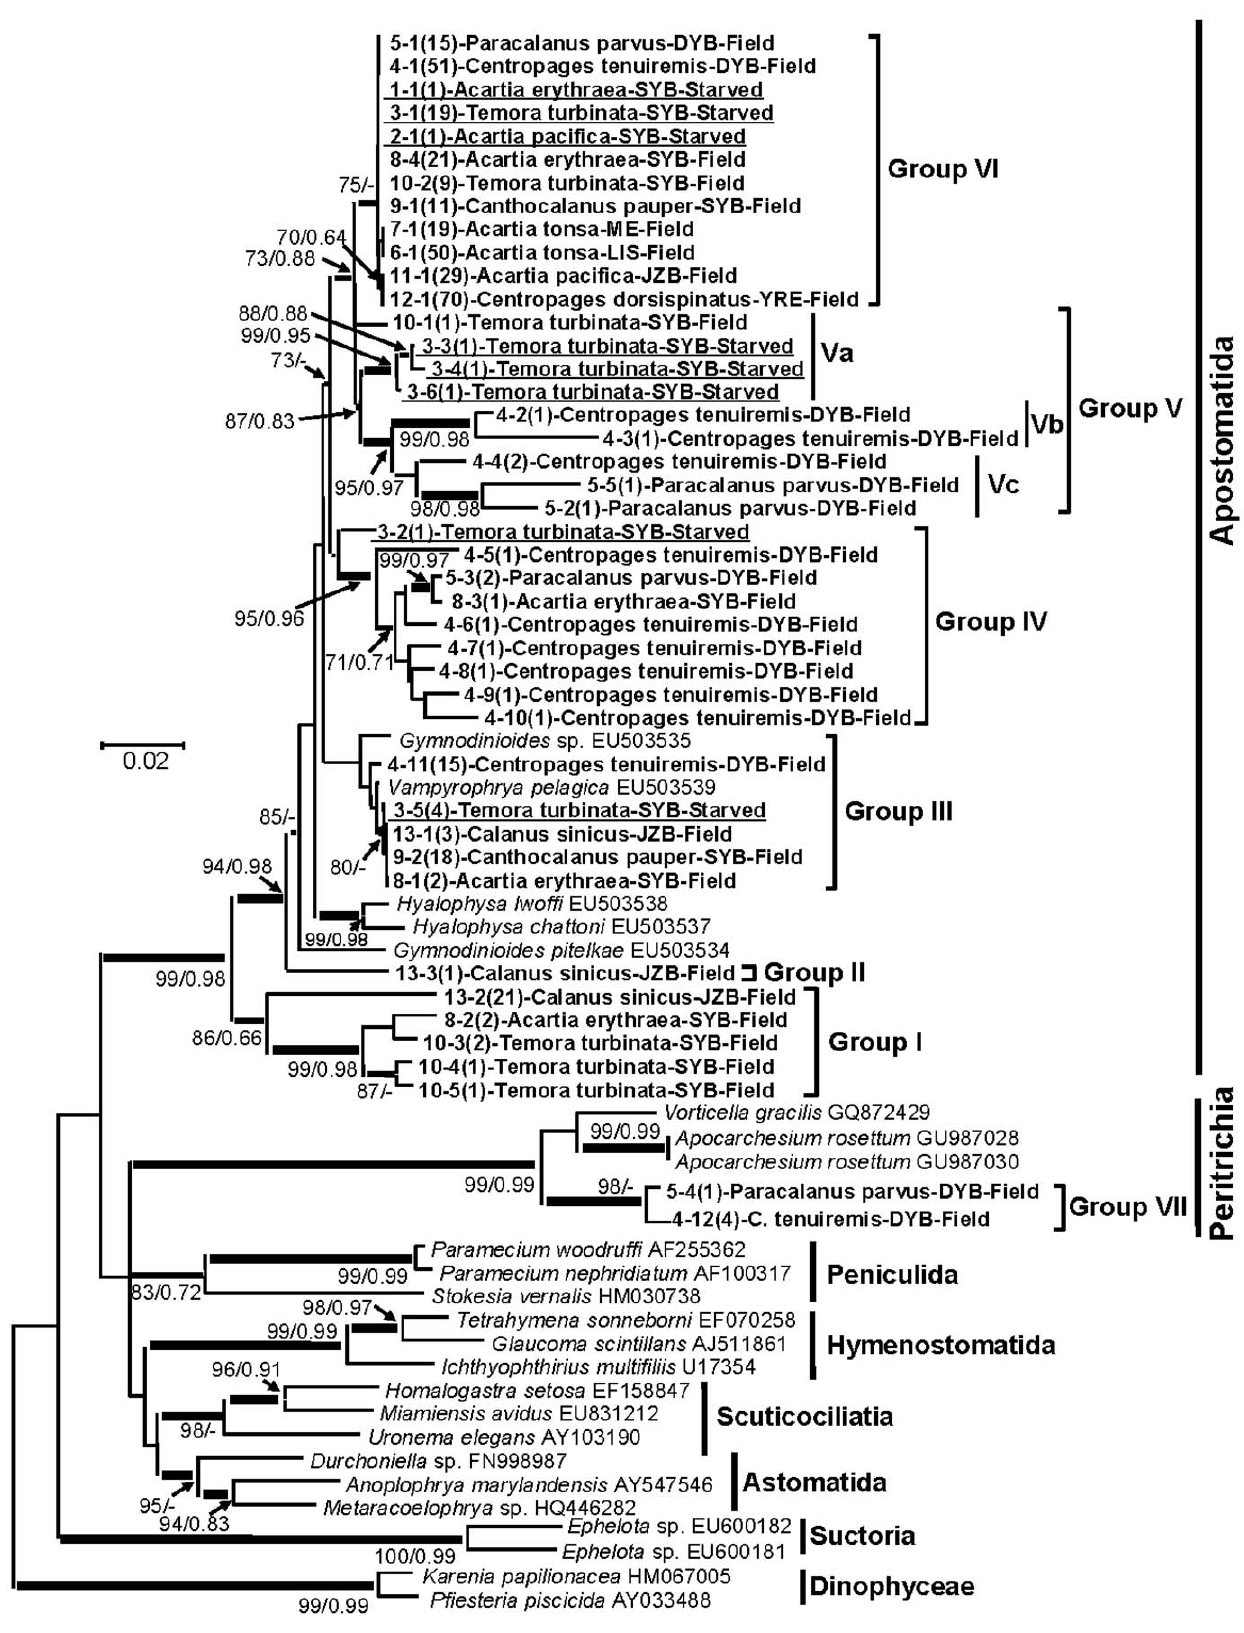
Figure 3. Neighbor joining and maximum likelihood analyses of 18S rDNA sequences. Phylogenetic tree inferred from partial 18S rDNA sequences retrieved in this study and the related organisms available in GenBank. Shown at nodes are bootstrap value from Neighbor-Joining (left)